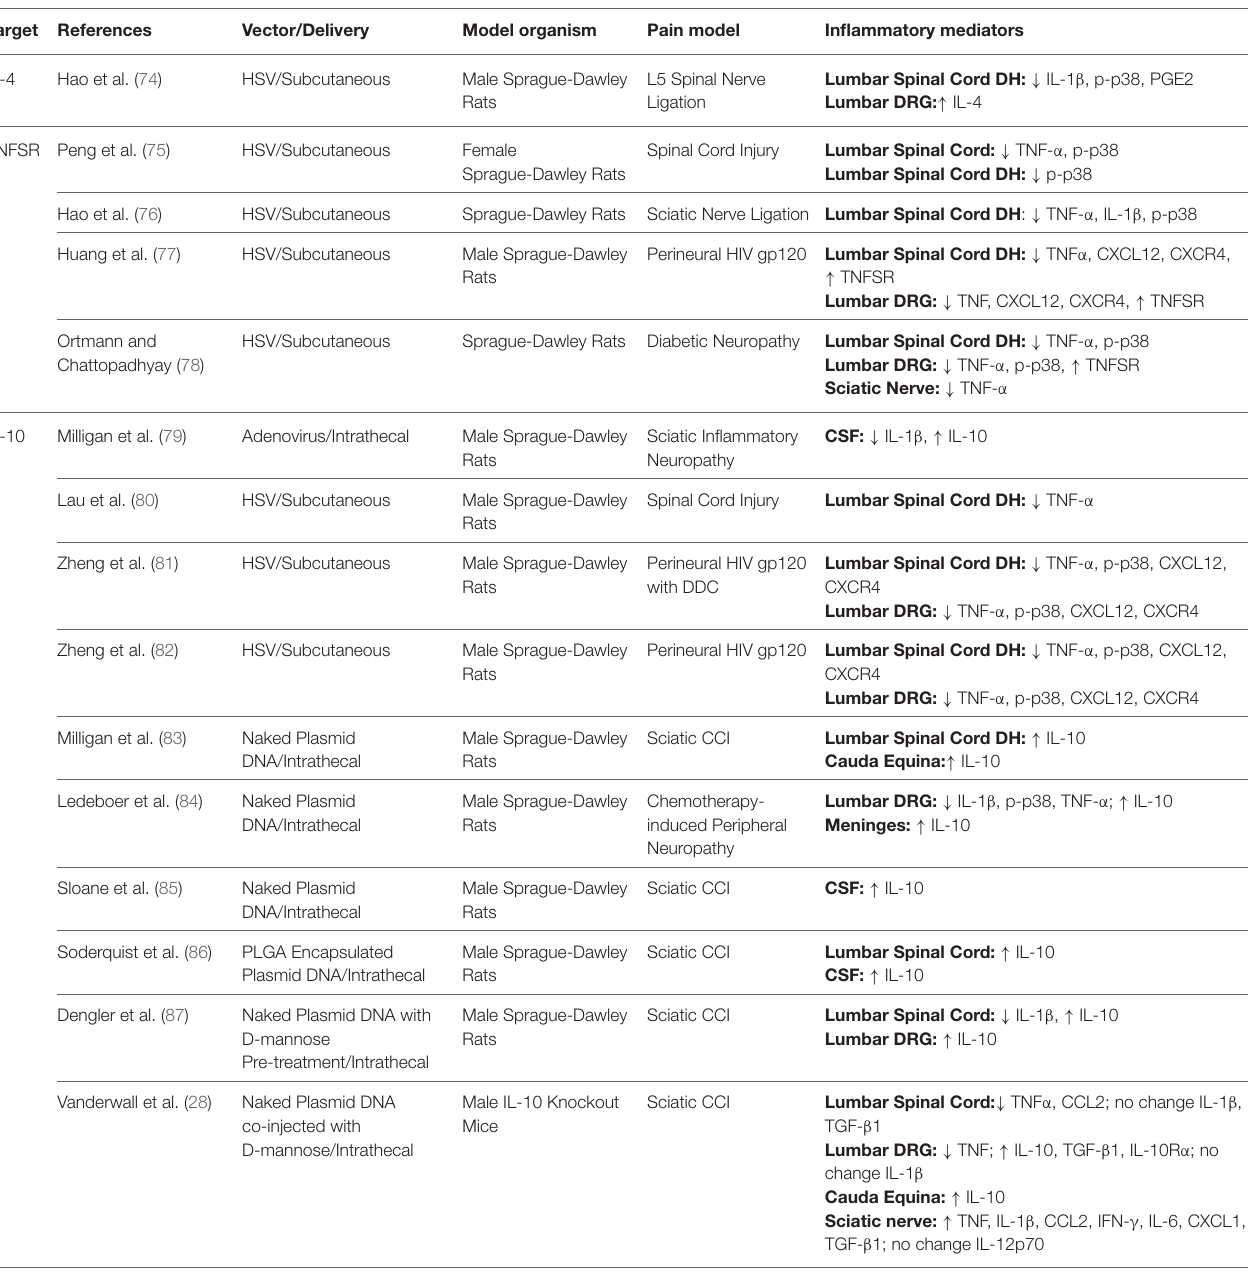
TABLE 1 | Anti-inflammatory gene therapies for treatment of pathological